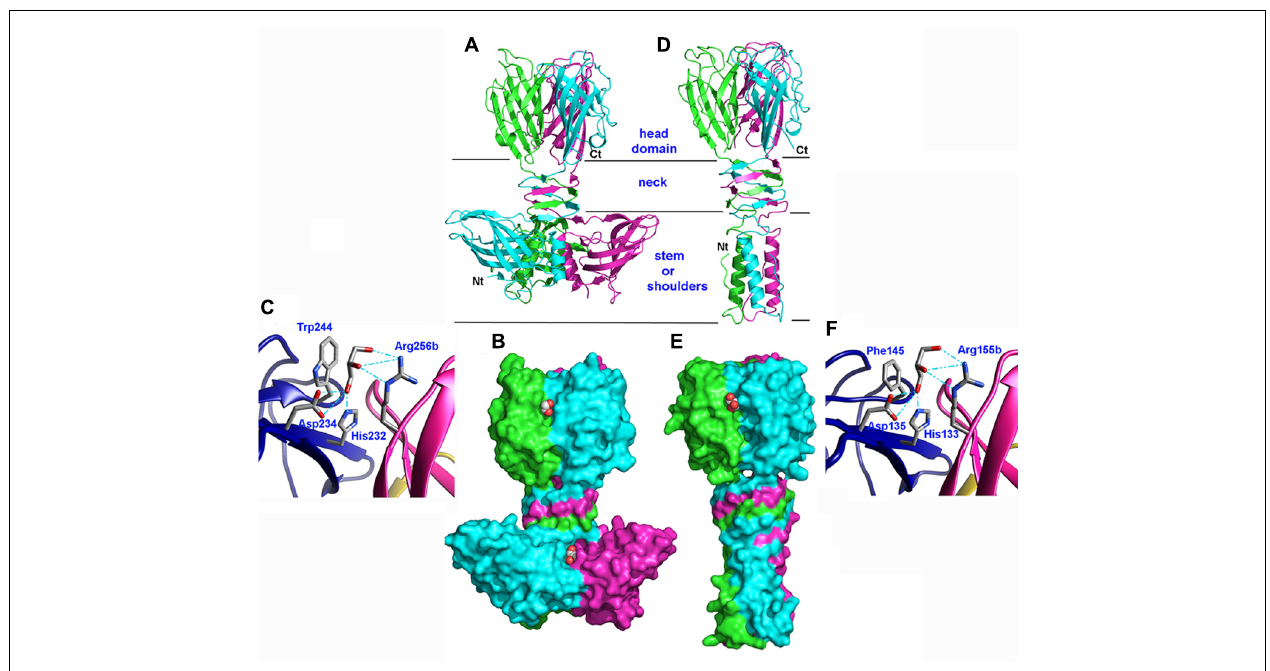
FIGURE 3 | Structures of the receptor binding proteins (RBPs) of phages p2 and TP901-1. (A,D) Ribbon view of the p2 RBP trimer (A) and of the TP901-1 RBP trimer (D) . Monomers are colored green, blue, and pink. (B,E) Surface representation of the p2 RBP trimer (B) and of the TP901-1 RBP trimer (E) . Bound glycerol molecules are represented